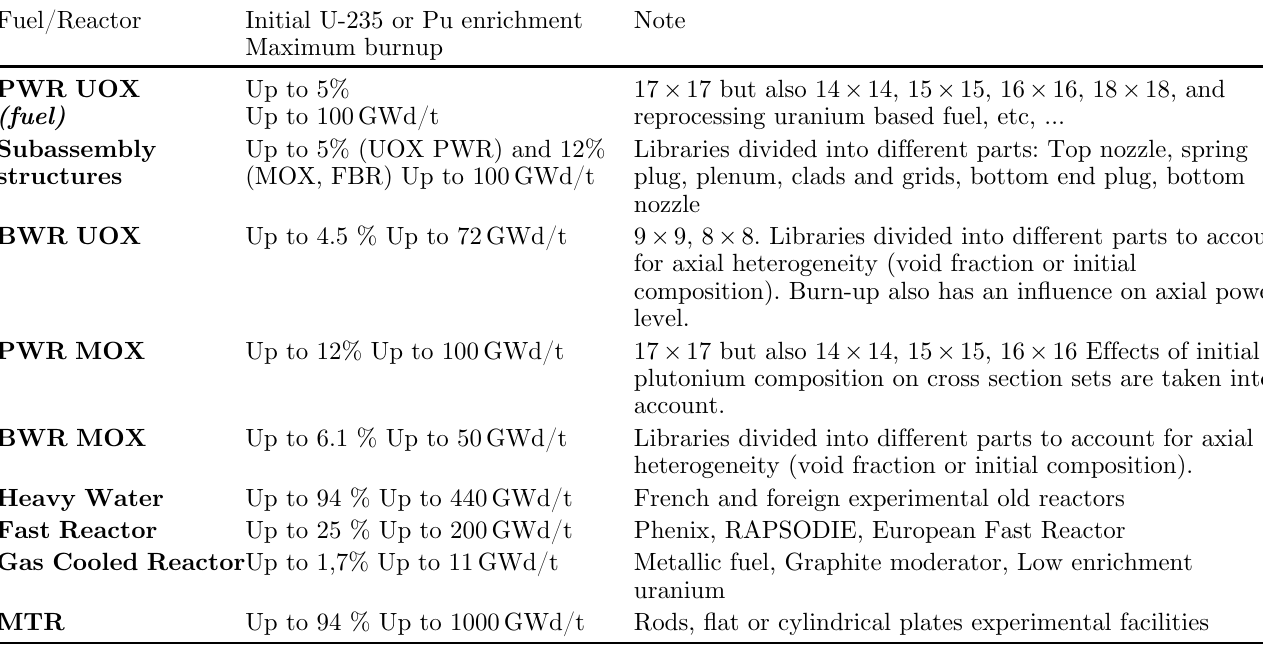
Table 2. Main core design libraries developed at CEA.